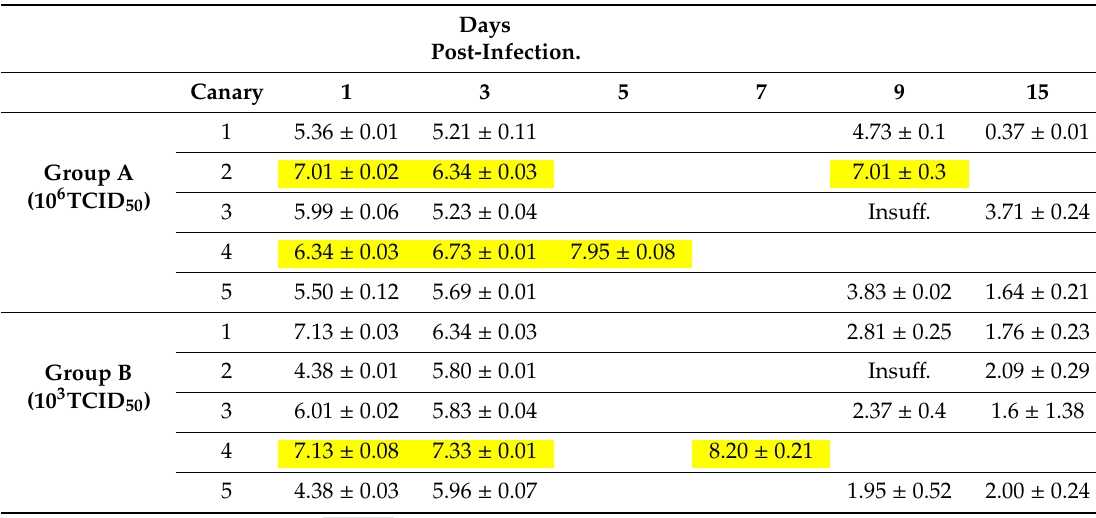
Dead canary; Insuff. = Insufficient